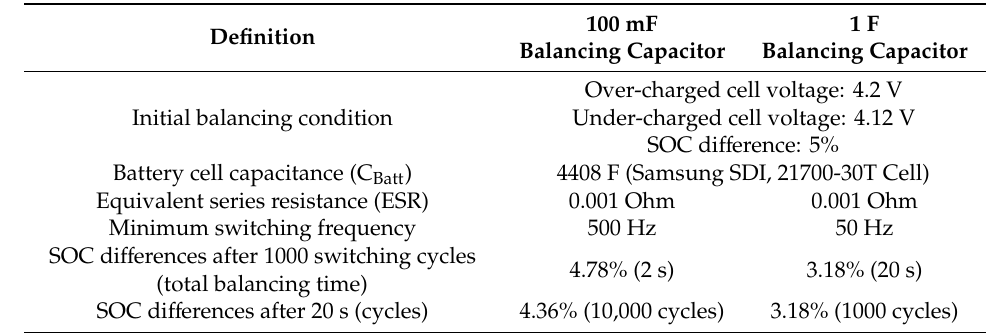
Figure 6. Trends of the cell voltages and the SOC differences with 1000 balancing cycles: ( a ) 100mF balancing capacitor; ( b ) 1F balancing capacitor. Table 5. Design and analysis of the ACB circuit.